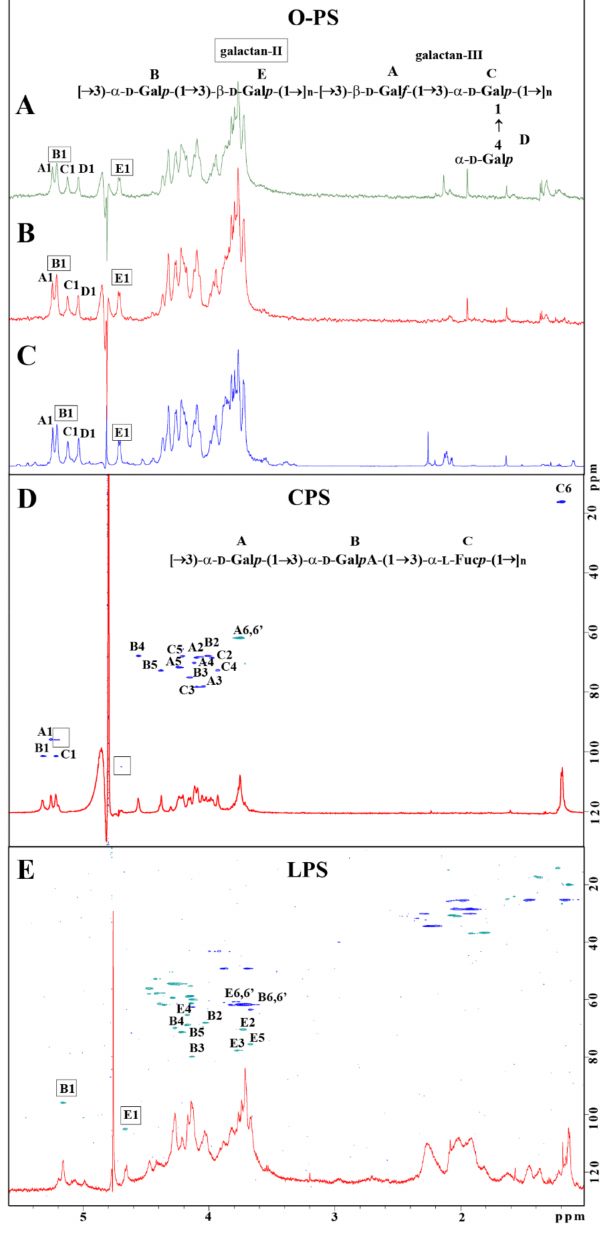
Figure 3. Structural analysis of carbohydrate surface antigens of K. pneumoniae Kp486 and